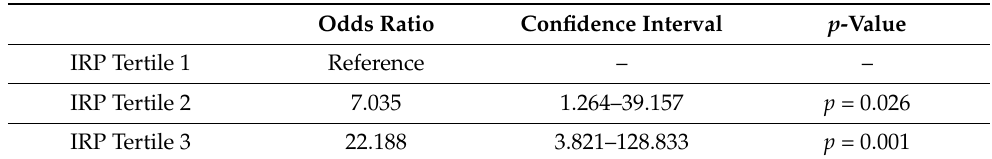
Table 3. Logistic regression Analysis Evaluating the Effect of IRP on the Likelihood of Dysphagia- predominant